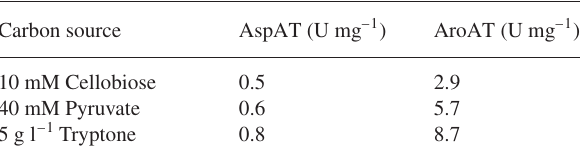
Table 4. Activities of AroATs and AspAT in crude extracts of P. furiosus grown on various carbon sources . Either 20 mM aspartate orphenylalanine,and 5 mM α -ketoglutaratewere usedassubstrates.